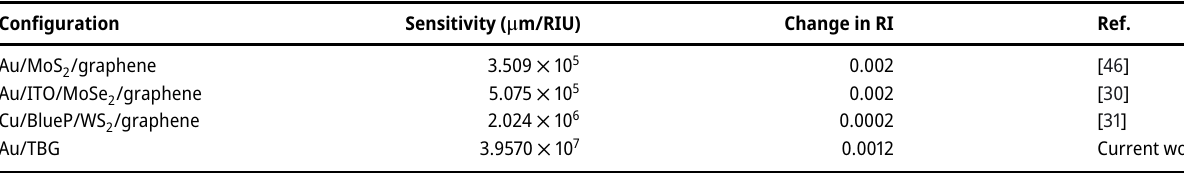
Table 3: Comparison of 2D plasmonic configurations under the excitation of 632.8